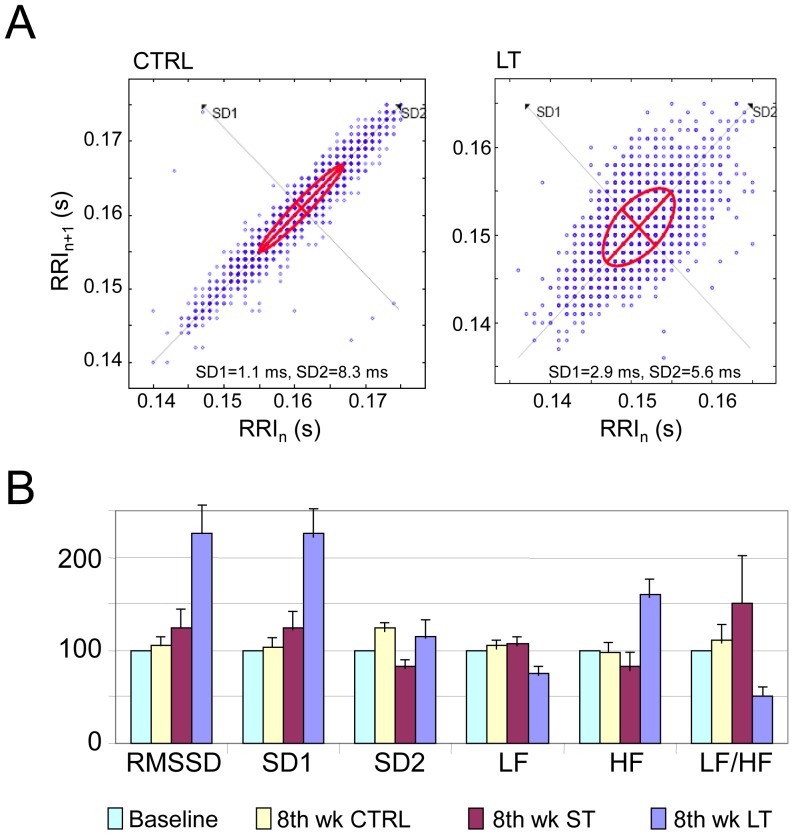
Heart rate variability measures.A. Poincare plots for sample CTRL and LT animals (comparison of ST group to CTRL was not significant, not shown). B. HRV parameters for the 3 groups relative to their normalized value at week 1 in %.